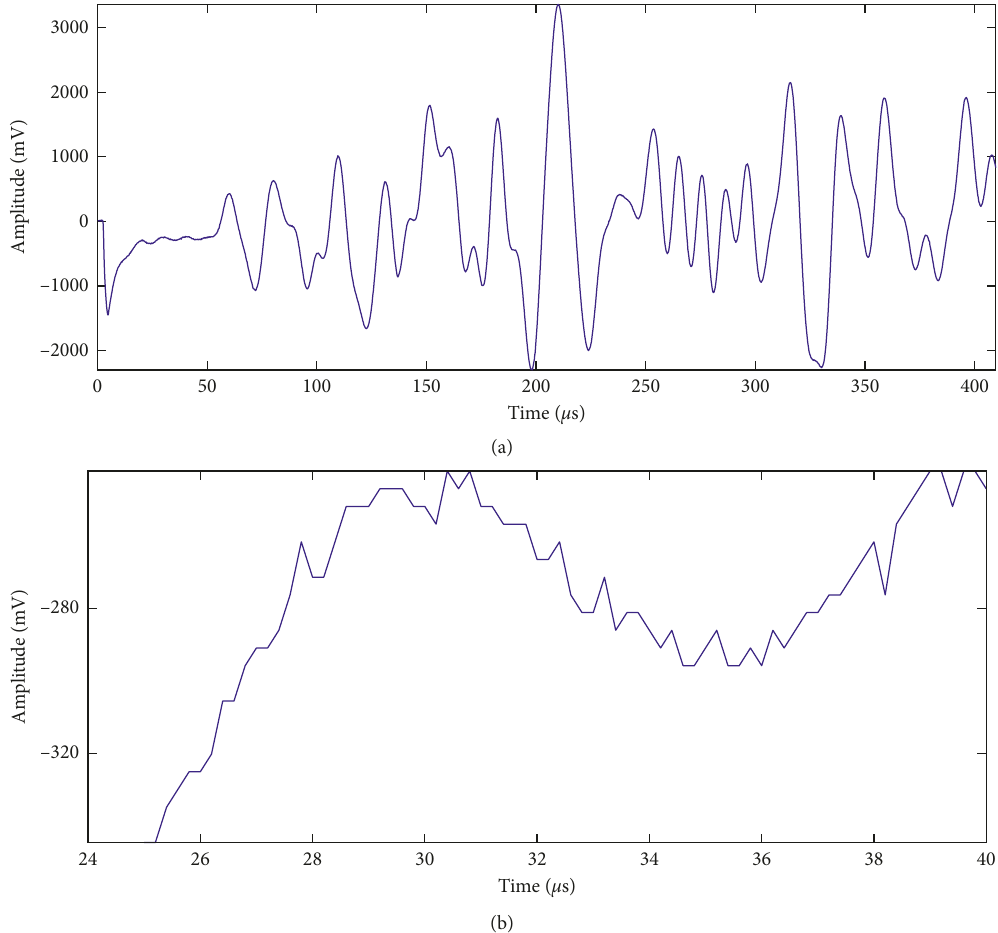
Figure 11: Time-domain curve (a) and minutiae (b) of nonlinear ultrasonic